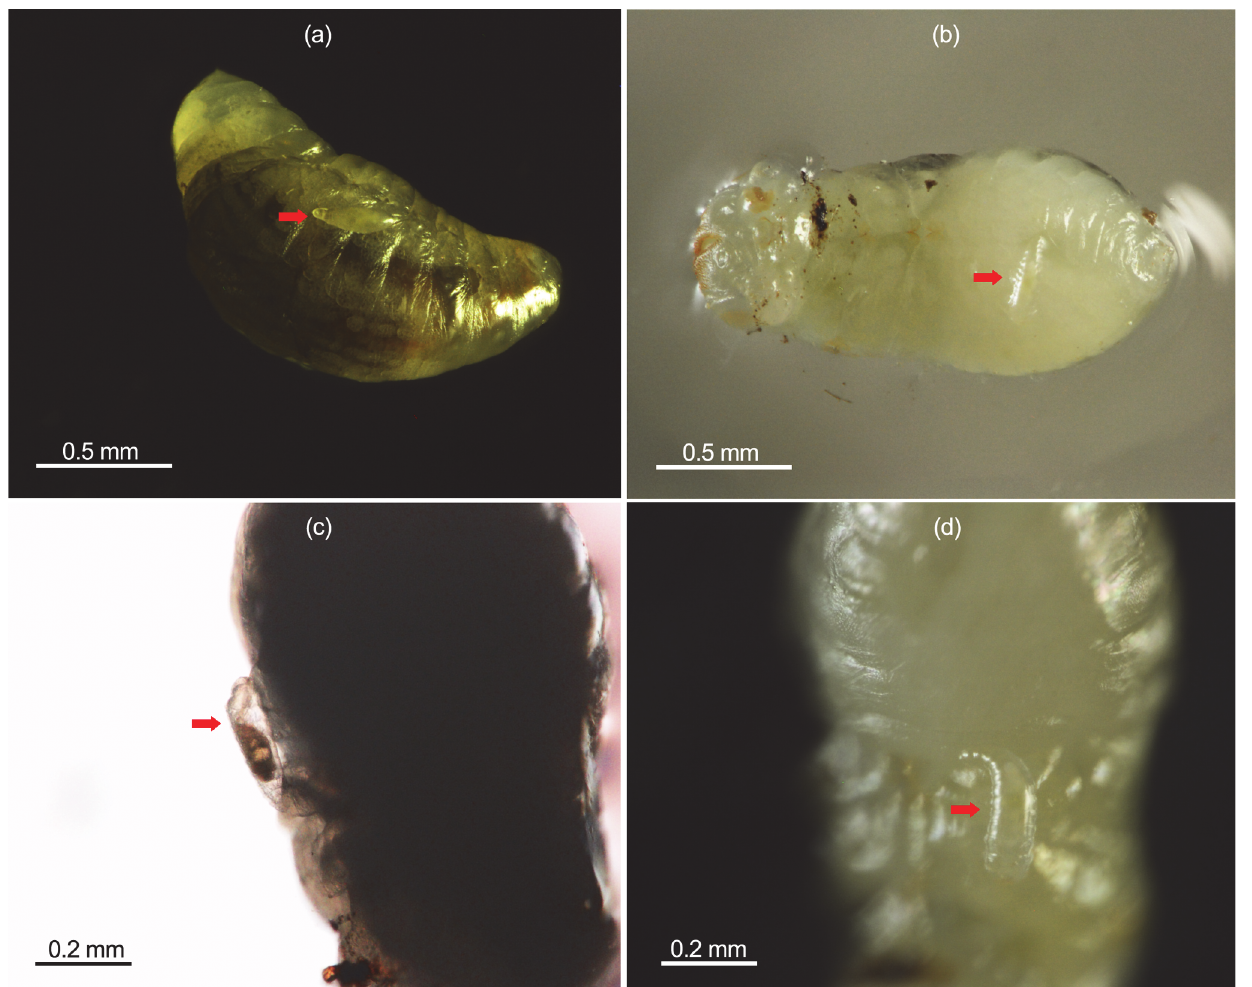
Fig 5. Eggs and larvae of secondary parasitoids on the prepupae of primary parasitoids. Eggs (a) were laid on the surface of the prepupae of primary parasitoids (infested nine days before). Larvae (b-d) fed on the primary conspecifics. Photograph by W